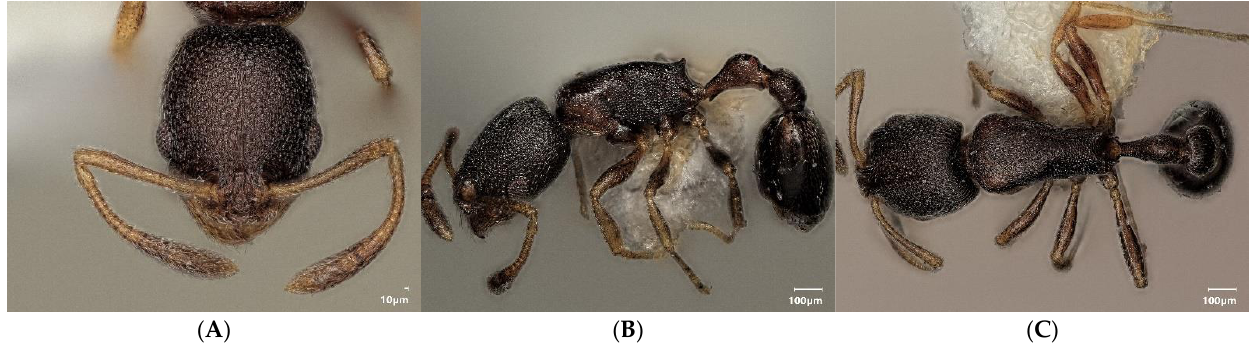
Figure 4. Cardiocondyla tjibodana : head in dorsal view ( A ), lateral view ( B ) dorsal view ( C ).